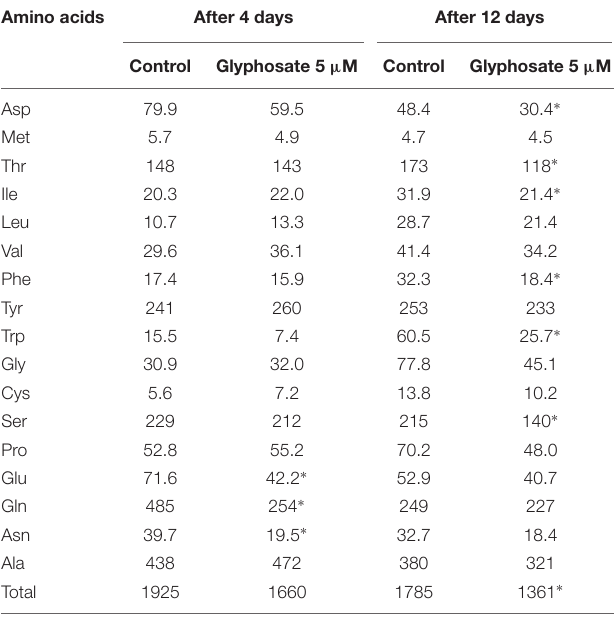
TABLE 5 | Free amino acid content (nmol g − 1 FW) in P. aegyptiaca callus grown in liquid BCGM with and without 5 µ M glyphosate. Amino acids